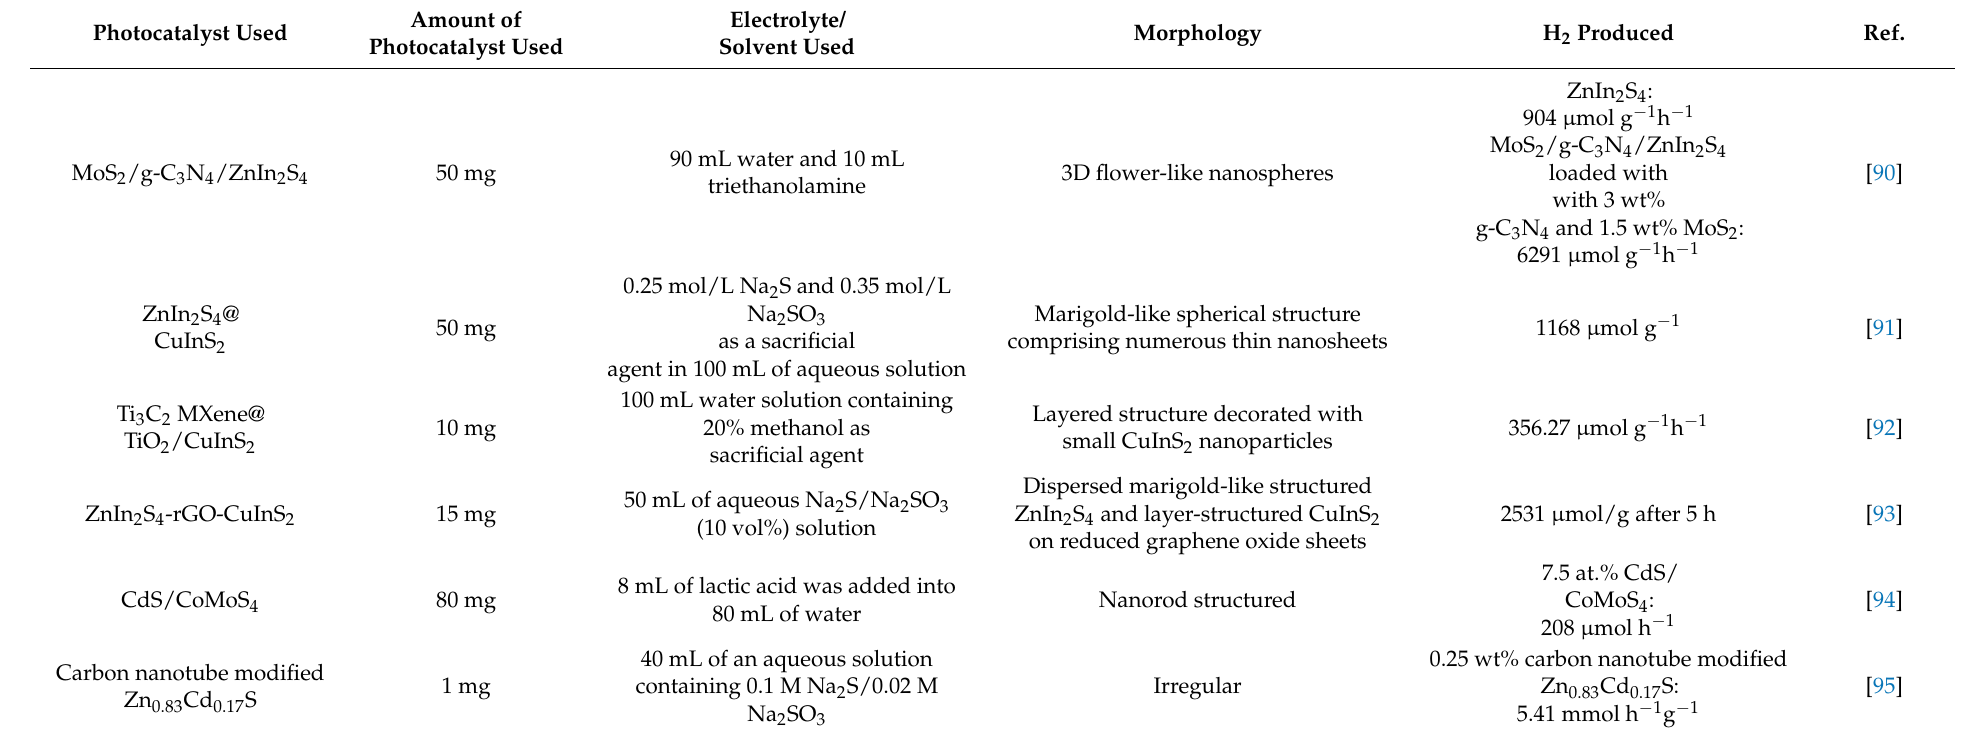
Table 2. Photocatalytic H 2 production activities using different ternary